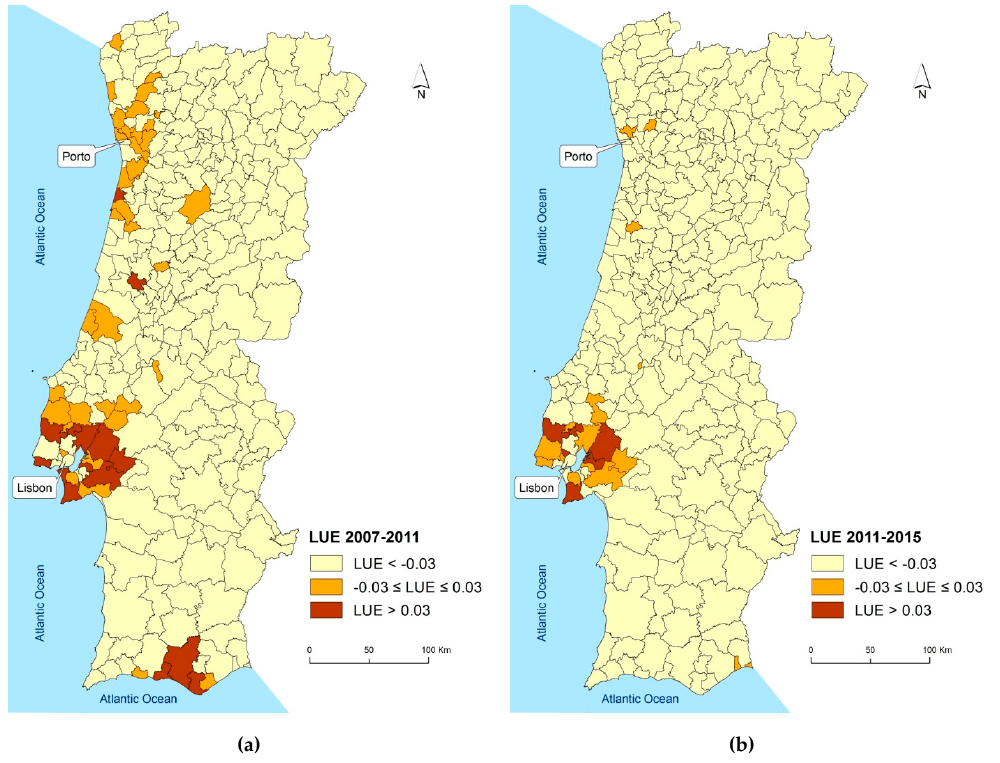
Figure 5. LUE estimates per municipality for 2007–2011 (a) and 2011–2015